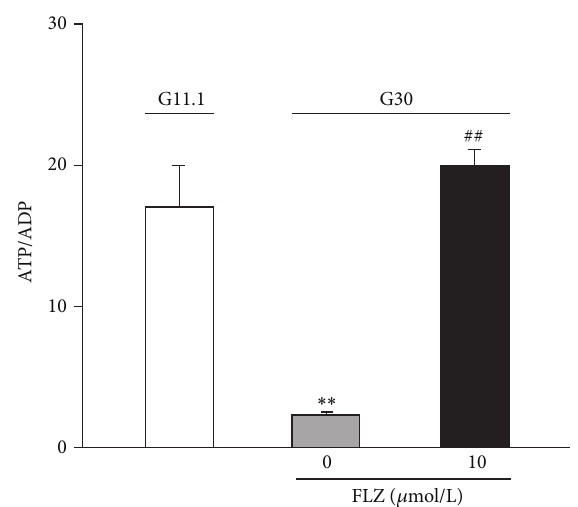
Figure 5: FLZ increases cytosolic ATP/ADP ratio at glucotoxicity. INS-1E cells were cultured at G11.1 or G30 for 3 days. Cells were treated without or with 10 𝜇 M FLZ. Data are mean ± S.E.M. of seven independent experiments. ∗∗ 𝑝 < 0.01 versus the value at G5.5; ## 𝑝 < 0.01 versus the value at G30 without